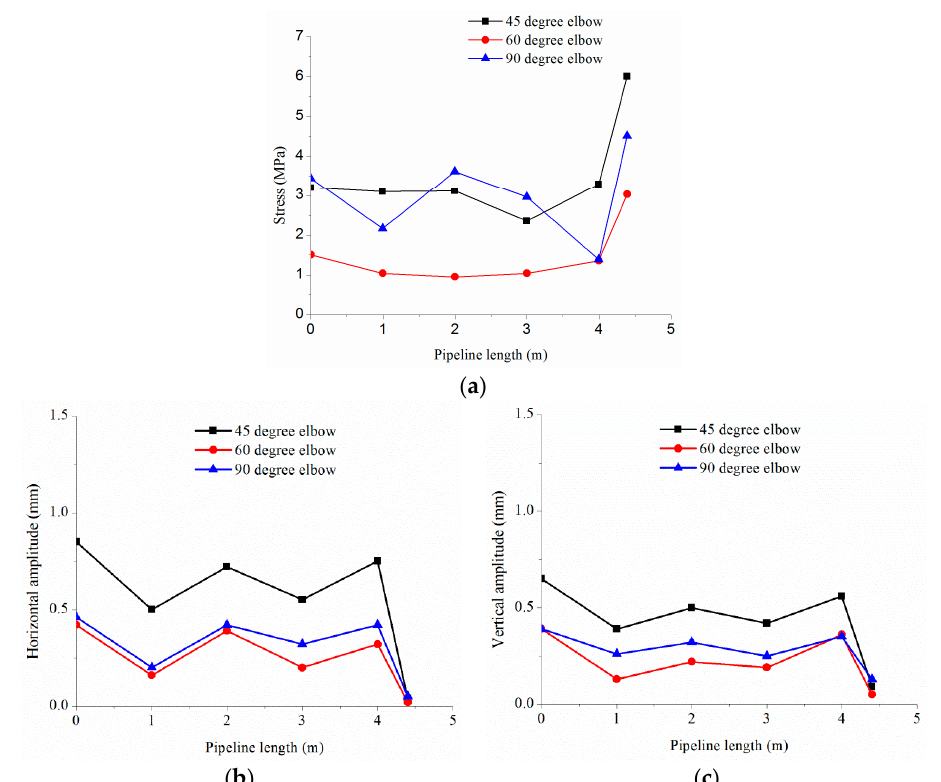
Figure 6. Horizontal and vertical amplitudes of pipelines with different elbow degrees: ( a ) stress; ( b ) horizontal amplitude; ( c ) vertical amplitude.